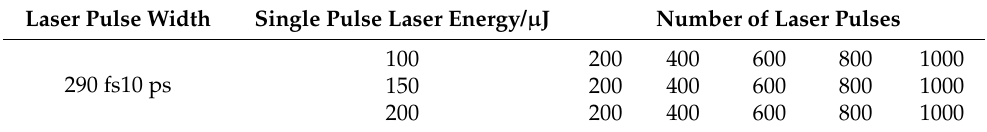
Table 1. Laser parameters in the